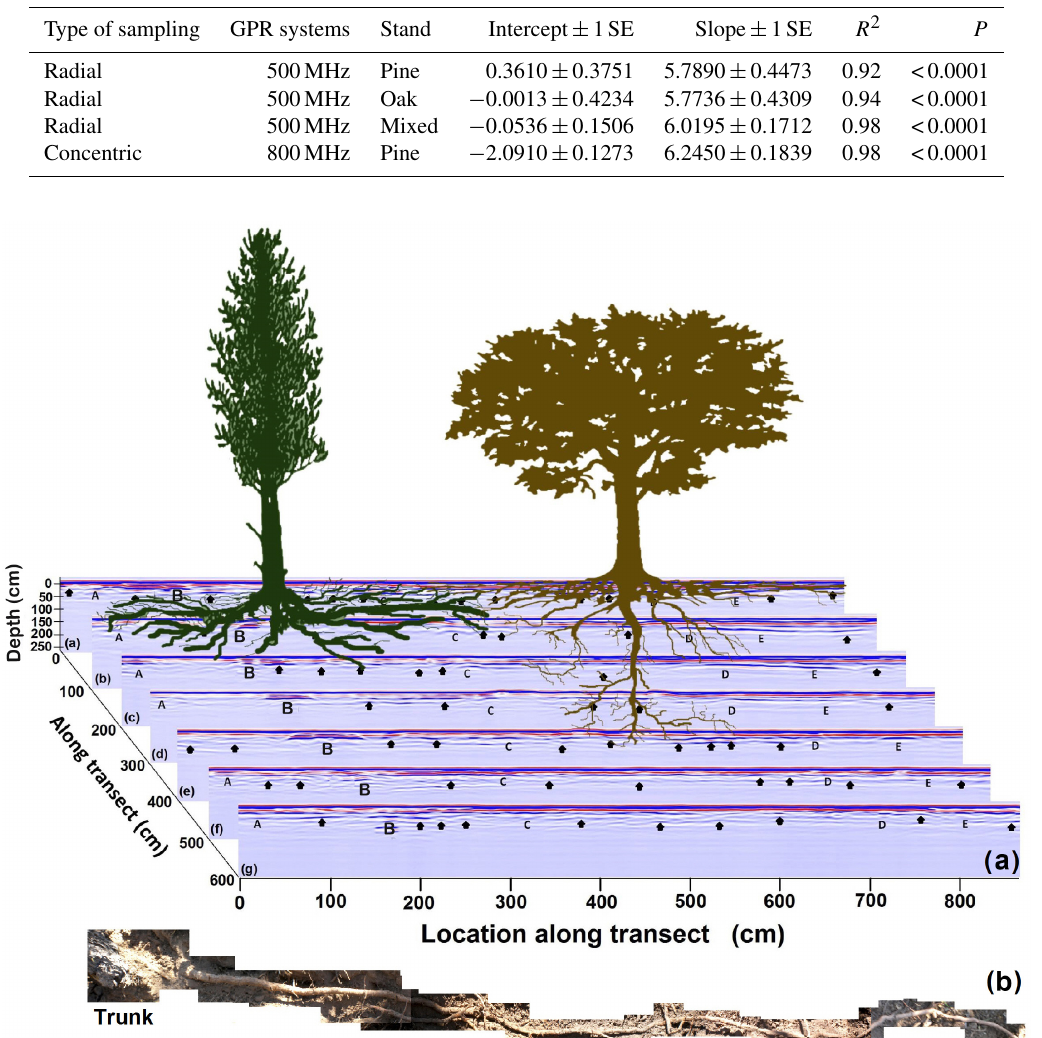
Table 4. Intercepts, slopes, regression coefficients and observed probabilities of linear regressions between root diameter (cm) and time interval (ns) which were used for calibration with both GPR systems for each sample type.